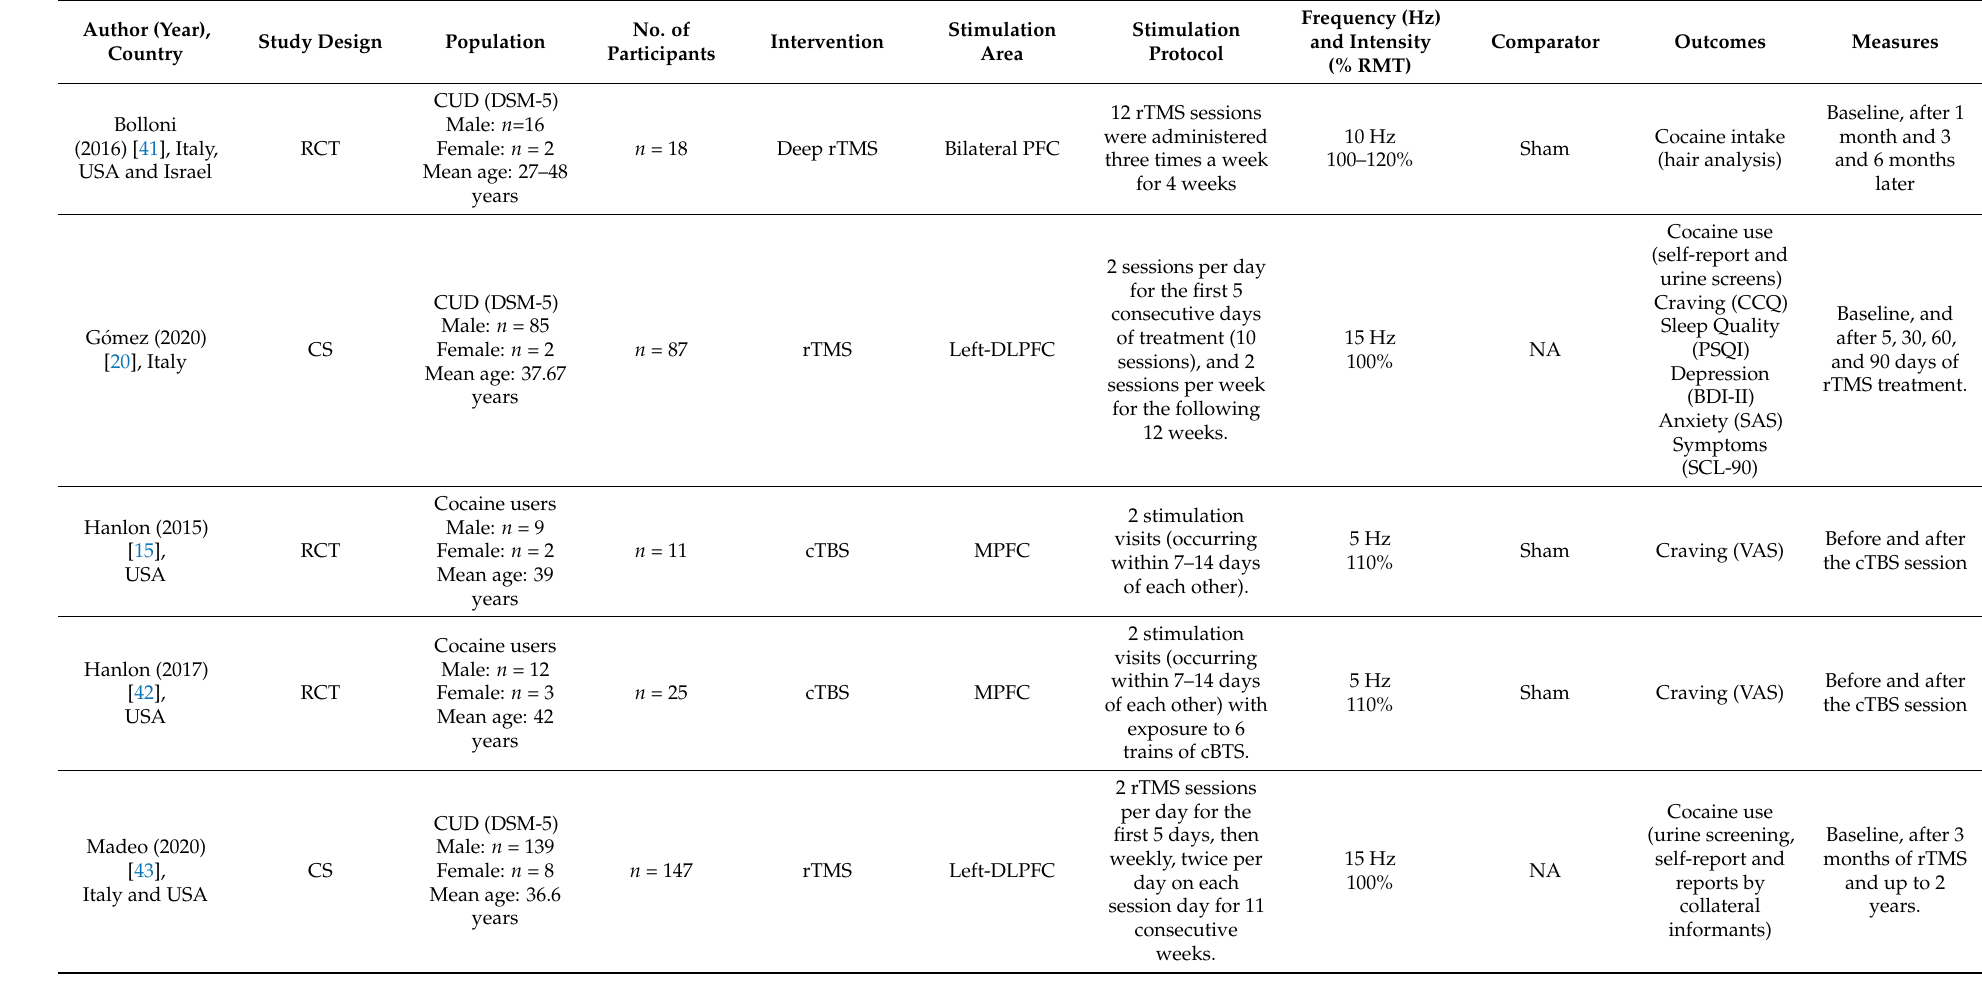
Table 2. Characteristics of the included